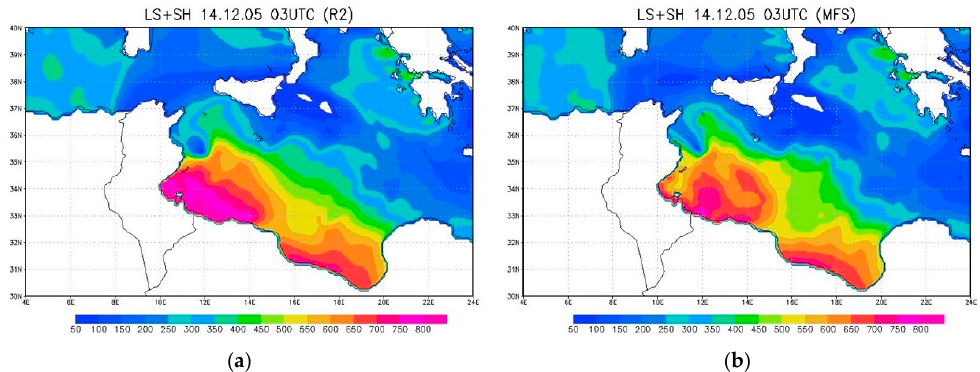
Figure 16. Latent heat + sensible heat fluxes (W/m*2) from ( a ) the R2 run and ( b ) the MFS run on 14 December 2005 03 UTC.